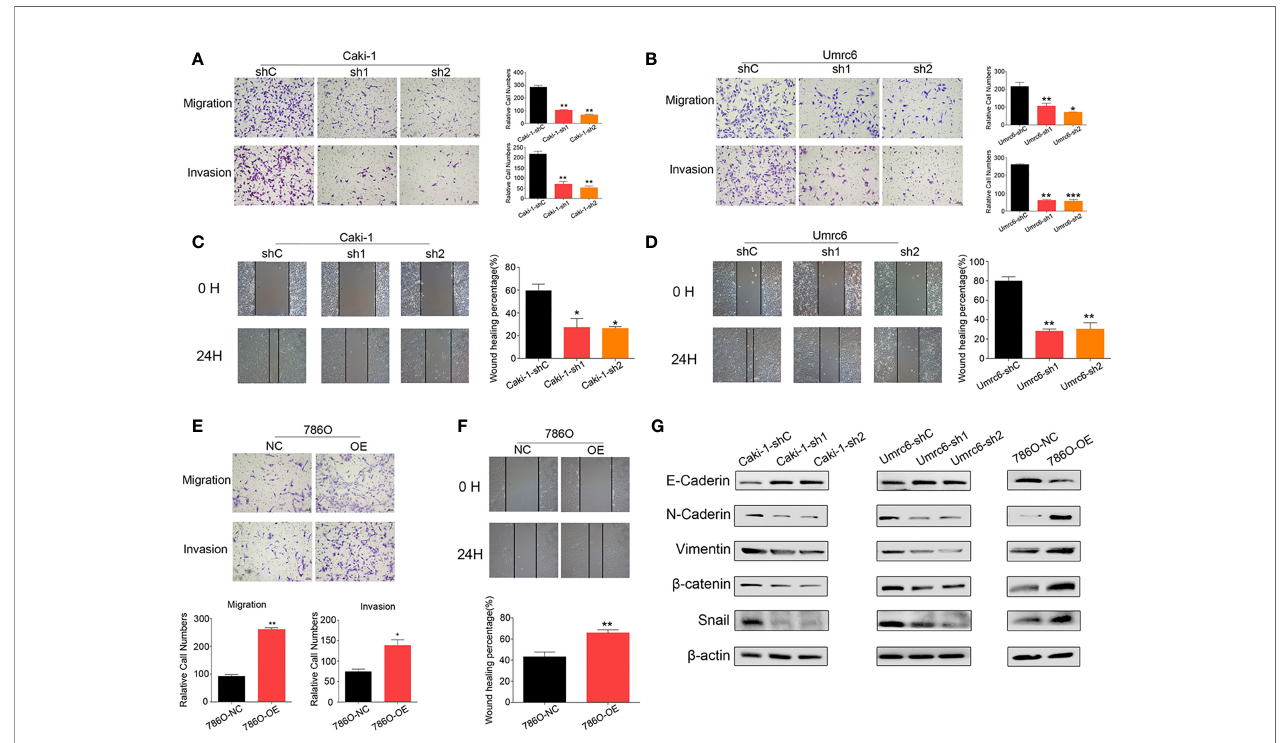
FIGURE 4 | DUXAP9 promoted the aggressive capacity of renal cancer cells and was involved with EMT. (A, B, E) Migration and invasion ability, as detected by Transwell assays without/with Matrigel, (C, D, F) wound healing assays, and (G) expression of EMT-related markers, as detected by western blotting, in renal cancer cells after DUXAP9 knockdown or overexpression. Data represent mean ± SD from three independent experiments. shRNA, short hairpin RNA; sh1, shRNA1; sh2, shRNA2; shC, shRNA negative control; OE, DUXAP9 overexpression; NC, overexpression negative control; EMT, epithelial – mesenchymal transition; *P < 0.05; **P < 0.01; ***P <